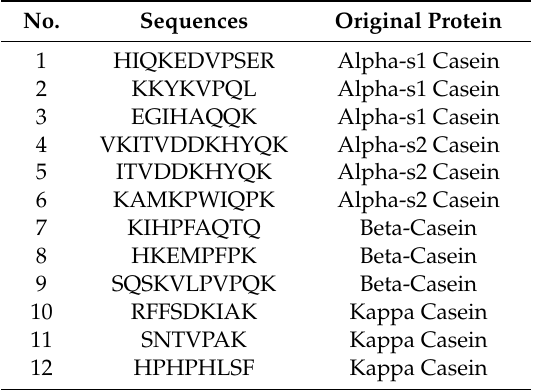
Table 1. Sequences of peptide contained in bioactive HPLC